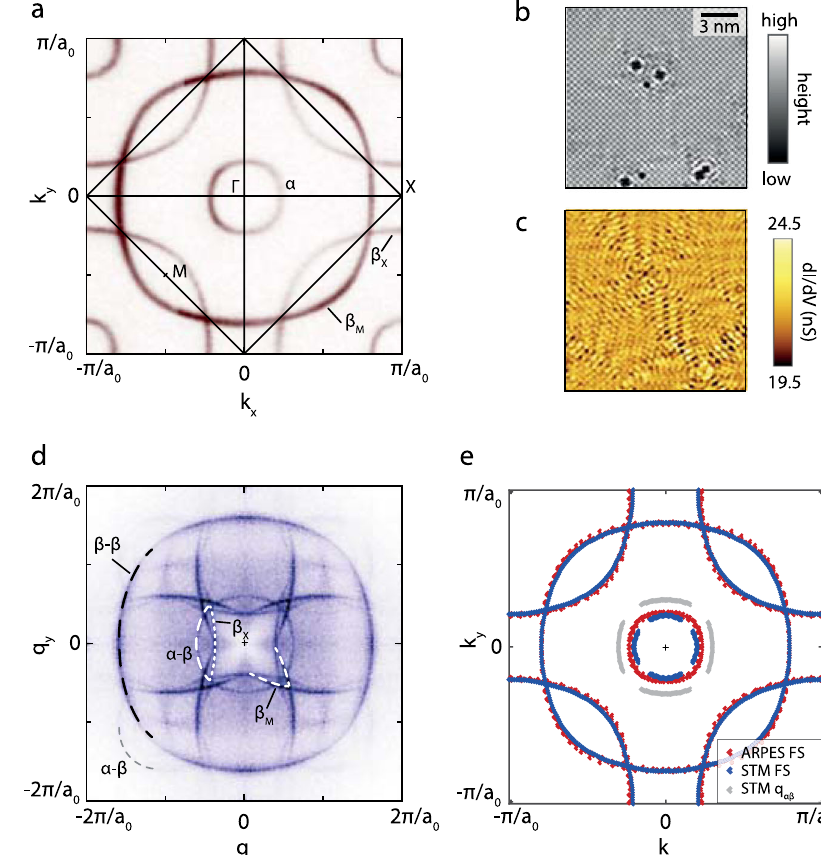
Fig. 1 Sr 2 RhO 4 Fermi surfaces. a ARPES Fermi surface. b STM topograph with atomic resolution showing presence of impurities. c STM conductance layer dI/dV ( r , eV ) at energy eV = − 20 meV, acquired simultaneously to the topograph in panel b , showing interference between quasiparticles standing waves patterns. d STM ‘ Fermi surface ’ , obtained by a two-dimensional Fourier transform of the conductance layer corresponding to the Fermi level of a spectroscopic map measured over a fi eld of view of 70 × 70 nm 2 . Here and for all QPI data, we show the normalized data, i.e., the Fourier transform of dI/dV ( r , eV ) /(I ( r )/ eV) , to mitigate the set-up effect (see Methods). The data is additionally symmetrized and the low-q components are suppressed with a 2D gaussian: raw data is shown in Supplementary Fig. 1. e Comparison between extracted Fermi surfaces of ARPES and STM. For completeness, we also show the QPI signal of q αβ , which was used in the derivation (see text and Supplementary Figs 2 and 3).